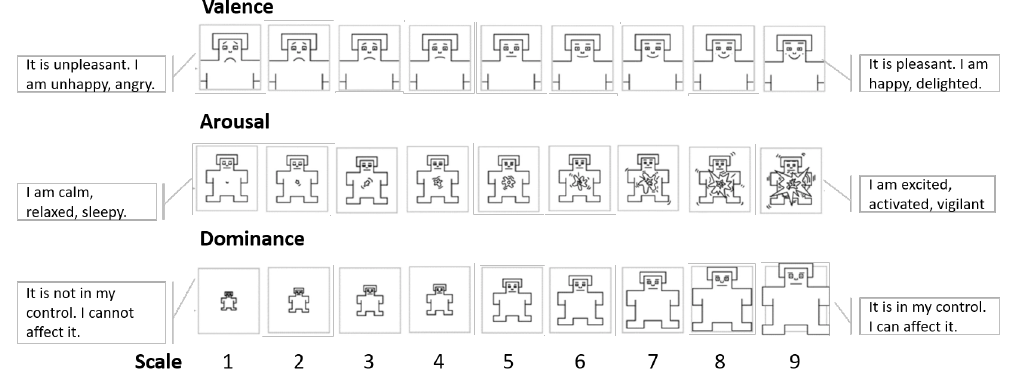
Figure 3. Self-assessment manikin (SAM) questionnaire and its scales, respectively, valence, arousal, and